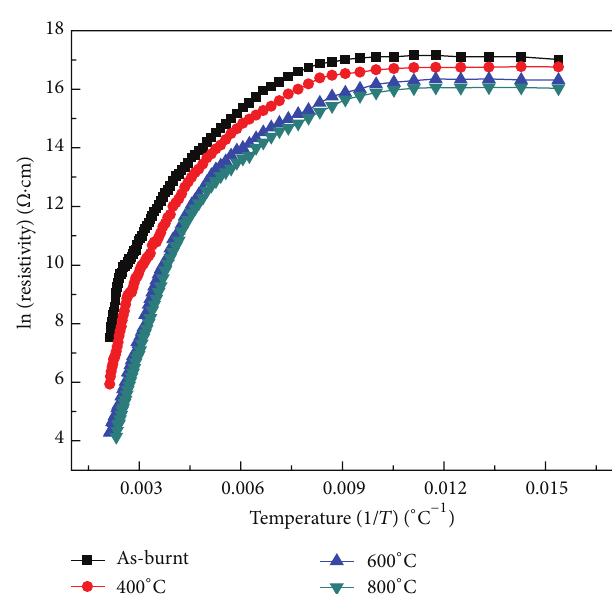
Figure 4: Temperature-dependent resistivity of as-burnt and annealed Zn 0.95 Mn 0.05